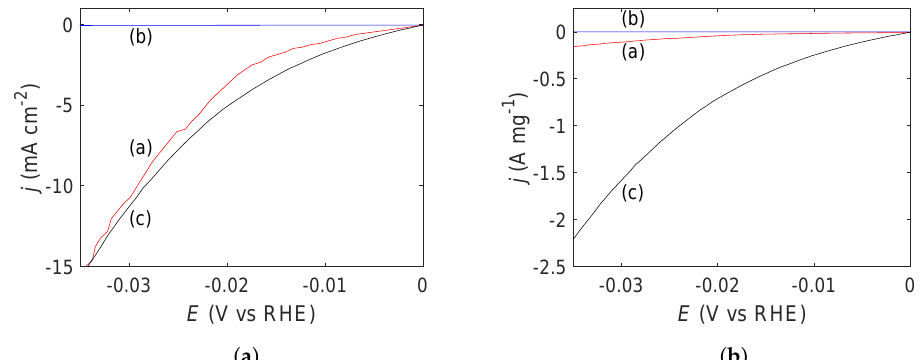
Figure 5. Linear sweep voltammogram acquired over the hydrogen evolution region for sonochemi- cally synthesized carbon supported Pt-nanoparticles (a), and Cu-nanoparticles before (b) and after (c) the addition of PtCl 4 . Figure ( a ) shows the current normalized for the geometric surface area, while Figure ( b ) shows the current normalized for the estimated mass of Pt.